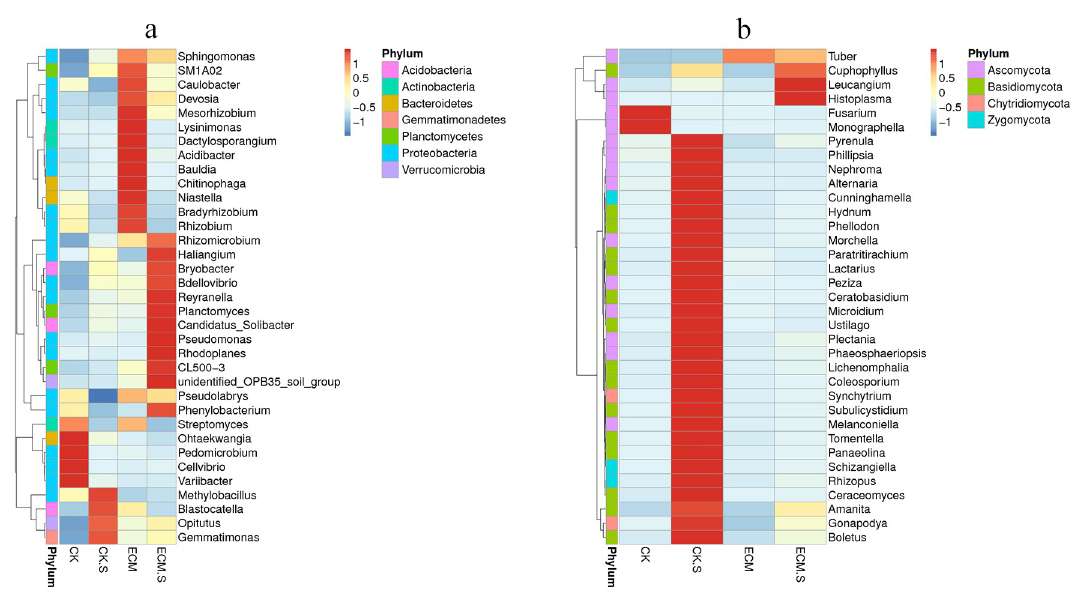
Fig 4. Heat-map analysis of the 35 most abundant bacterial and fungal genera in Pinus armandii roots and surrounding soils. ECM and ECM.S, ectomycorrhizae ( Pinus armandii in associationwith Tuber indicum )and ectomycorrhizospheresoil. CK and CK.S, roots and soils from cultivated P . armandii without T . indicum partner. a, bacterial genera; b, fungal genera. The relative abundance of the sample at genuslevel increasedwith the increaseof the color block